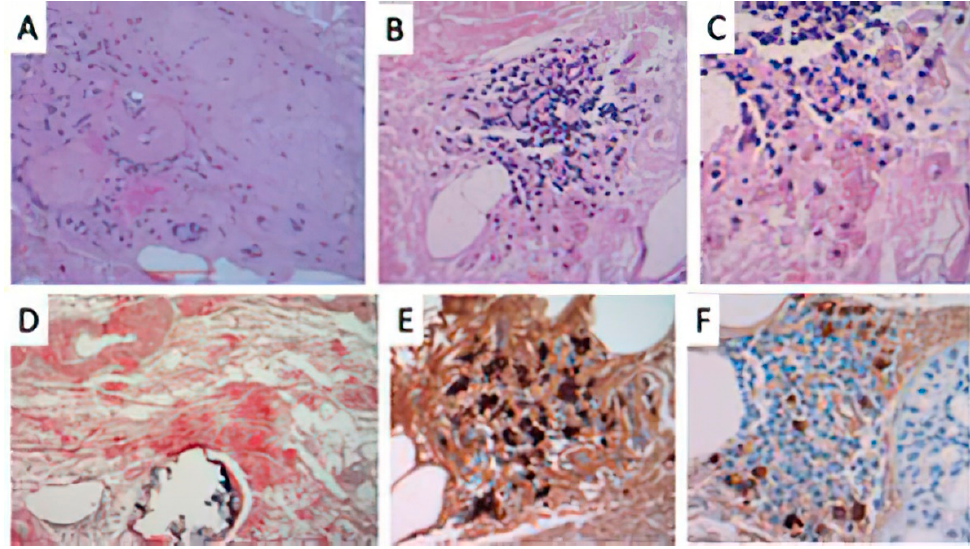
Figure 4. Histopathological findings of Case 3. ( A ) presence of a hyaline-like, amorphous eosinophilic material in the dermis surrounding and involving dermal vessels. (HE original staining ×40); ( B ) A perivascular and interstitial lymphocytic infiltrate (original magnification ×100) with ( C ) focal plasma cells component (original magnification ×400). ( D ) Congo red stained positively the amorphous eosinophilic deposits of amyloid in the dermis, surrounding deep dermal vessels (original magnification ×100). Immunohistochemical studies for ( E ) lambda and ( F ) kappa light chains showed evidence of lambda light-chain restriction, consistent with a monoclonal plasma cell proliferation.